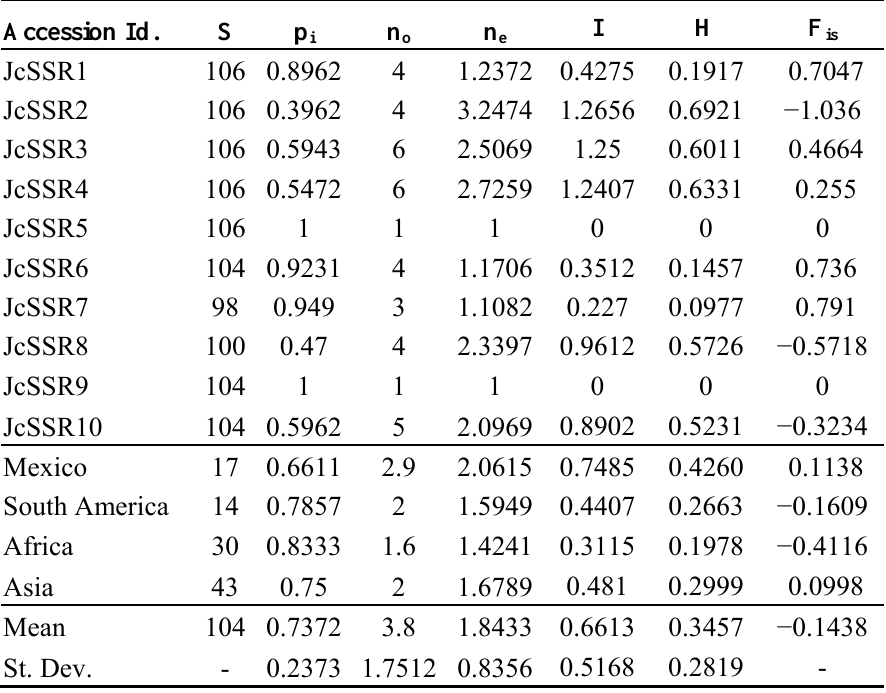
Table 3. Descriptive statistics of J. curcas germplasm related to SSR markers and accession groups. Sample size of marker alleles (S), frequency of the commonest